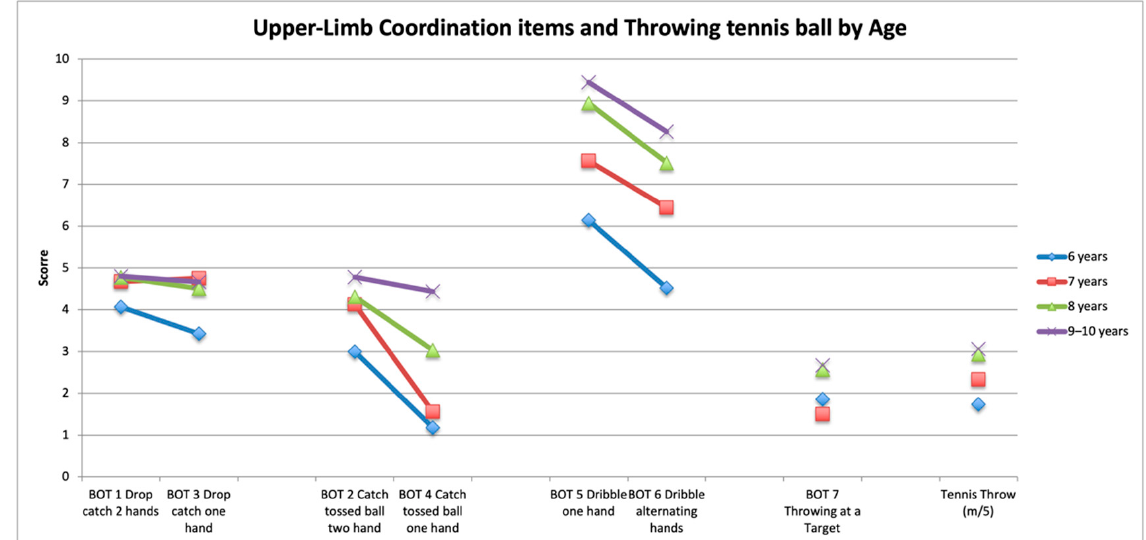
Figure 3. Upper-limb coordination items and throwing tennis ball by age. Items of the standardized tests for the different age groups available for only some of the children (BOT upper-limb coordination subtest n = 88 and Fitness Test Battery tennis throw n = 162). Tennis distance is presented in total meters divided by 5 to adapt the range.